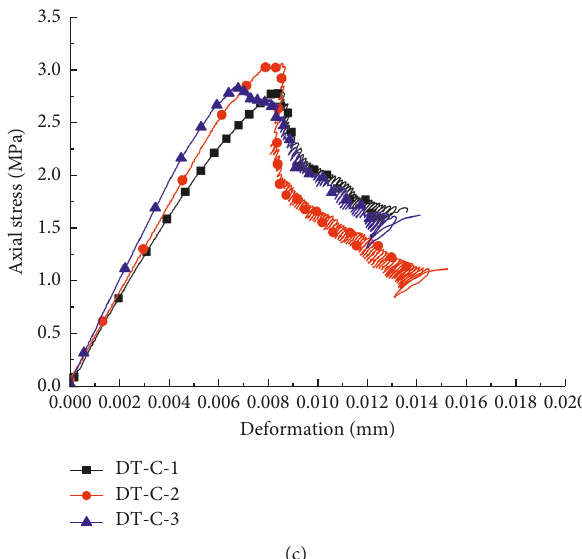
Figure 4: Axial-stress-deformation curves under different strain rates by experimental. (a) 10 − 6 s − 1 ; (b) 10 − 5 s − 1 ; (c) 10 − 4 s − 1 .